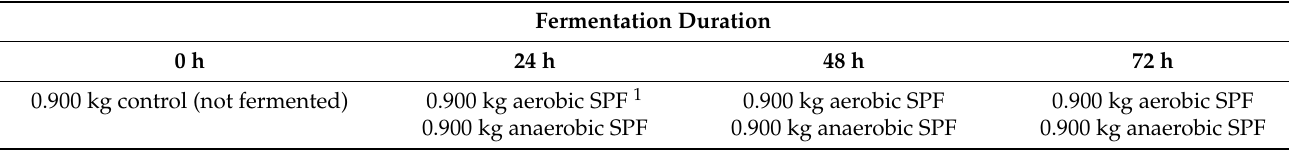
Table 4. Laboratory experiment